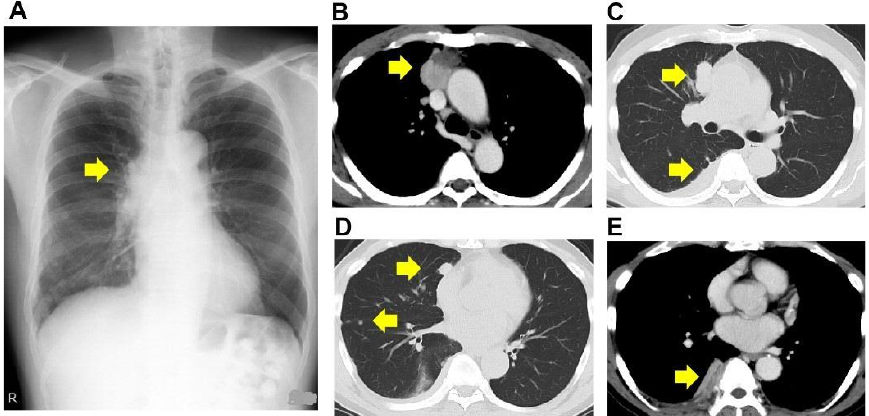
Figure 1. Radiological findings. Plain radiograph ( A ) and computed tomography ( B – E ). The com- puted tomography revealed a tumor between the anterior mediastinum and the right lung upper lobe ( B , C ), multiple nodular shadows along the right pleura ( D ), and pleural effusion ( E ). Arrows indicate the lesion.